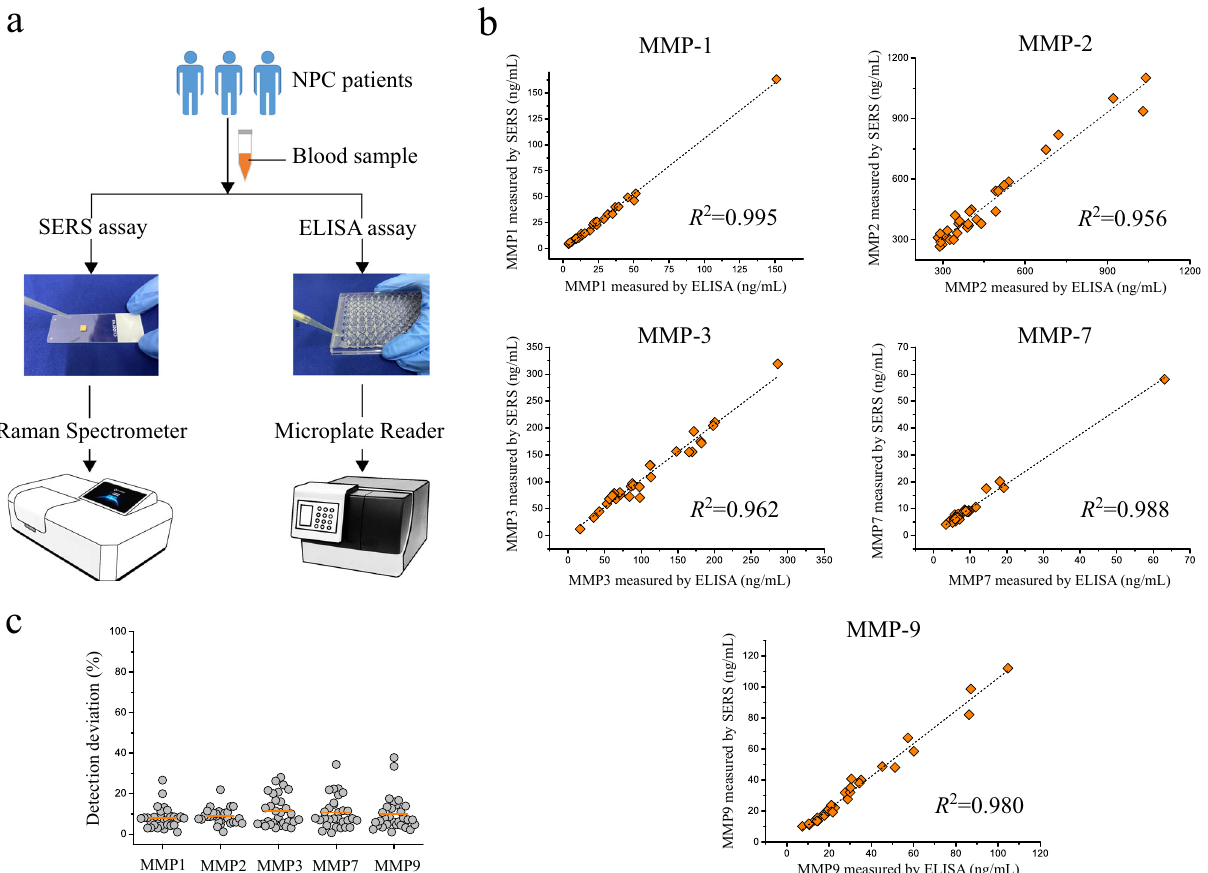
Fig. 7 Performance of SERS sensor. a Schematic of MMP detection using SERS and ELISAs. b Concordance between concentrations of MMP measured by SERS and ELISAs for MMP-1, MMP-2, MMP-3, MMP-7 and MMP-9. c Scatter plots of the detection deviation for SERS and ELISA tests. The orange line represents the mean